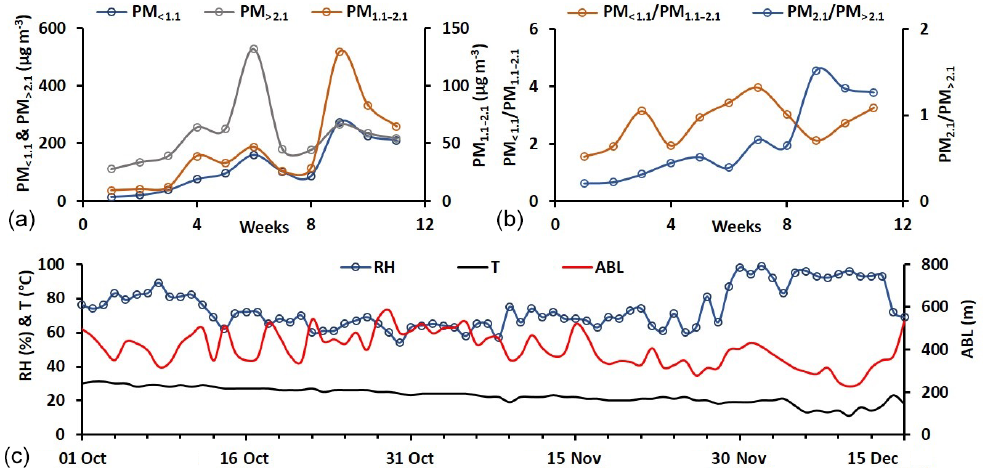
Figure 2. Time series of (a) size-segregated particulate mass concentration, (b) particle ratio, and (c) daily means of meteorological